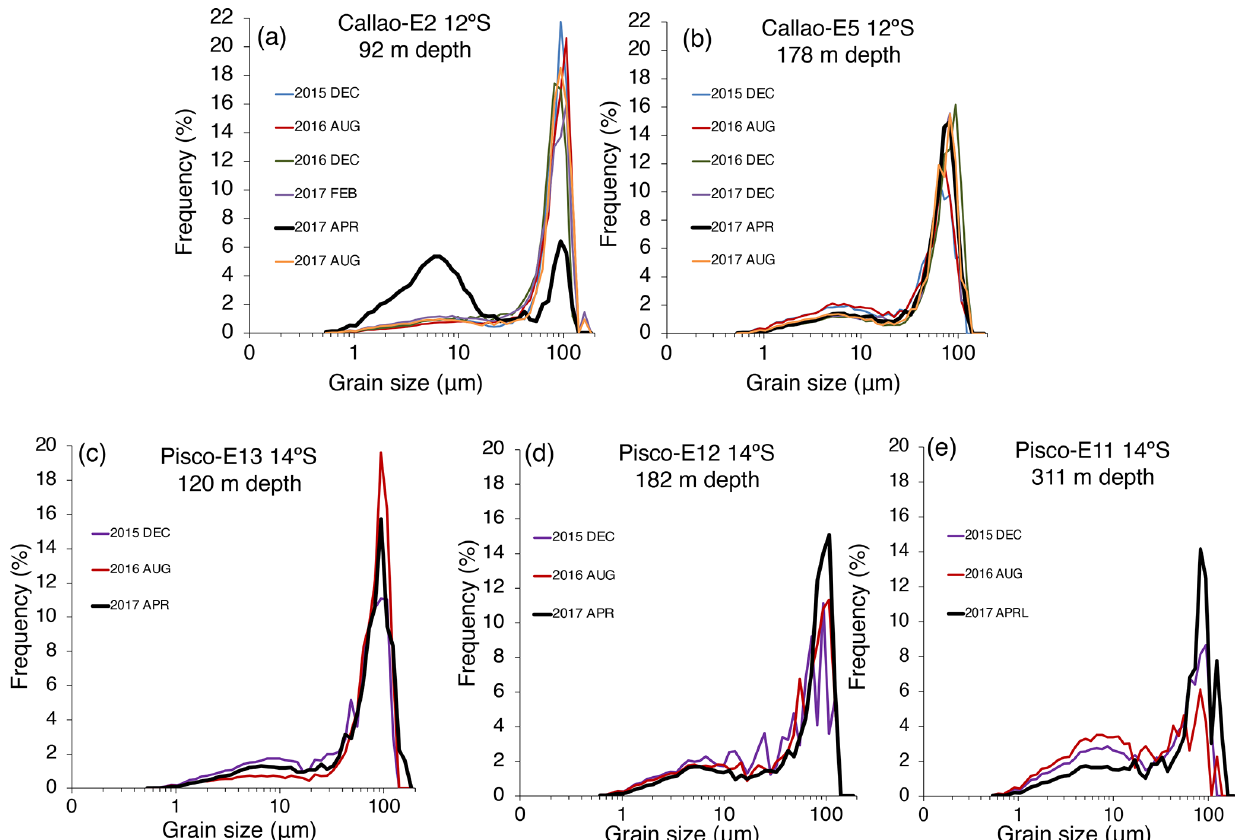
Figure 2. Grain-size distribution of surface sediments at the Callao (a, b) and Pisco stations (c, d, e) .